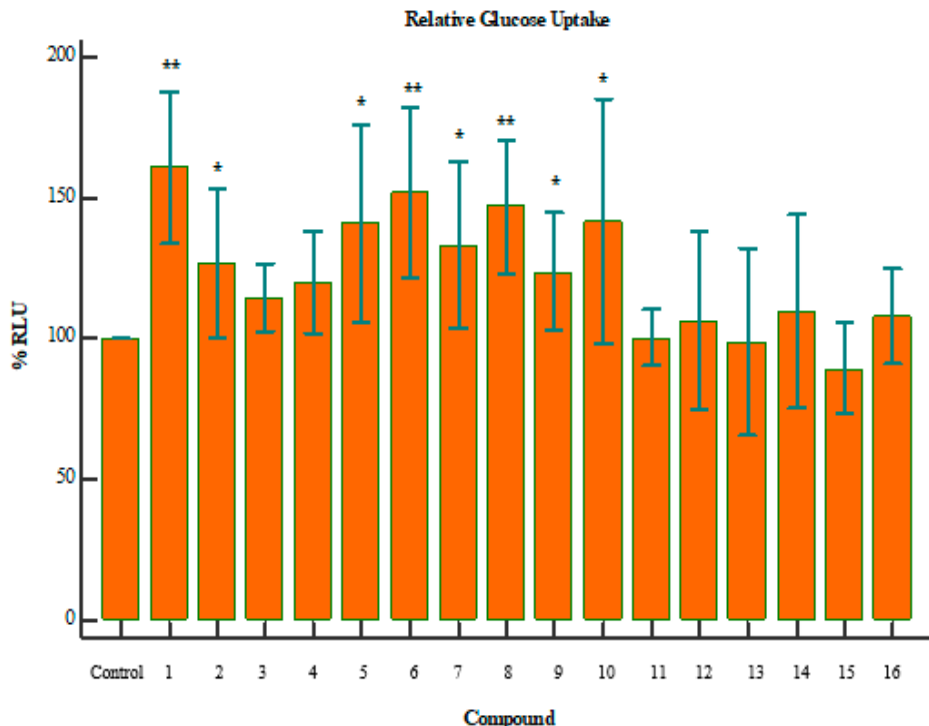
Figure 2. Relative glucose uptake of compounds 1 – 16 ; where the p -value is indicative of the statistical significance versus the control, using an independent two-tailed T-test. * p < 0.05 , ** p < 0.01 . Compounds 1 ( p = 0.0031), 8 ( p = 0.0053), and 6 ( p = 0.0086) showed a marked increase in glucose uptake.